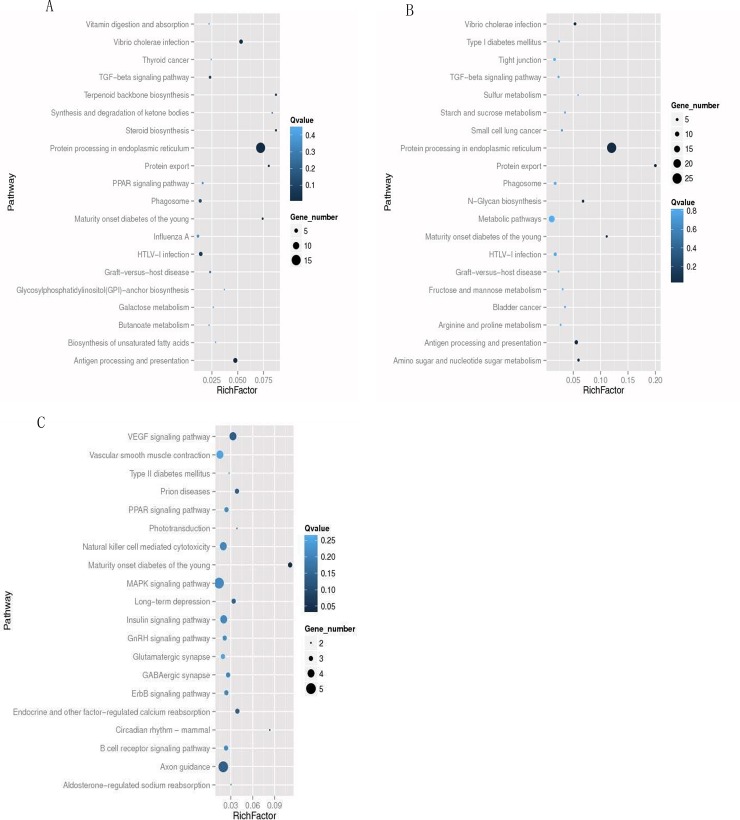
Statistics of pathway enrichment.A Statistic of Pathway Enrichment for con Vs TG, B Statistic of Pathway Enrichment for con Vs TG, C Statistic of Pathway Enrichment for con Vs HG+PA.